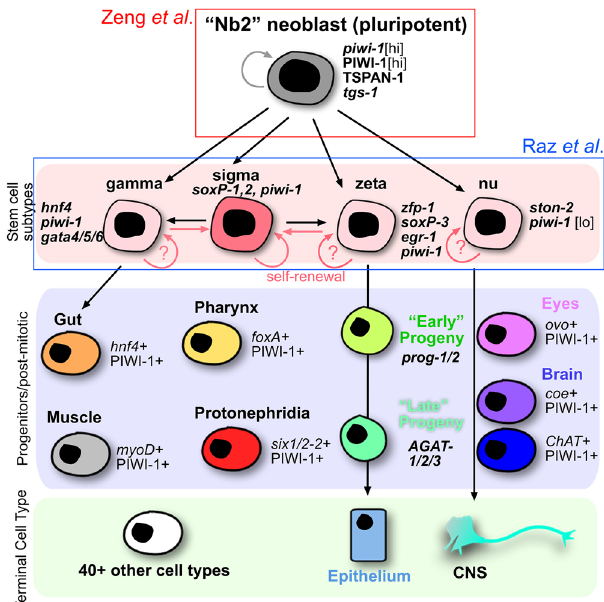
Fig. 1 Working model of the planarian stem cell hierarchy. At the top of the stem cell hierarchy in planarians must sit a pluripotent stem cell. Zeng et al. (red box) show support that this cell expresses tgs-1 and can be prospectively isolated by TSPAN-1 protein expression. Below the pluripotent neoblast may sit various molecular subtypes of neoblasts thus far described in planarians. Relatively little is known about the self-renewal or potency of any cell types at the stem cell subtype level, but the sigma class is likely to contain some pluripotent stem cells and is colored darker than the other cells. Raz et al. (blue box) demonstrate that the cNeoblast may not exist in the hierarchy, and that stem cell subtypes may have the ability to retain pluripotency and switch between stem cell types. Raz et al. also show that as stem cells exit the cell cycle, their commitment to a progenitor state and lineage is likely to occur. Some progenitor cells for speci fi c tissues and lineages have been found and others are not yet associated with a given lineage (no connecting